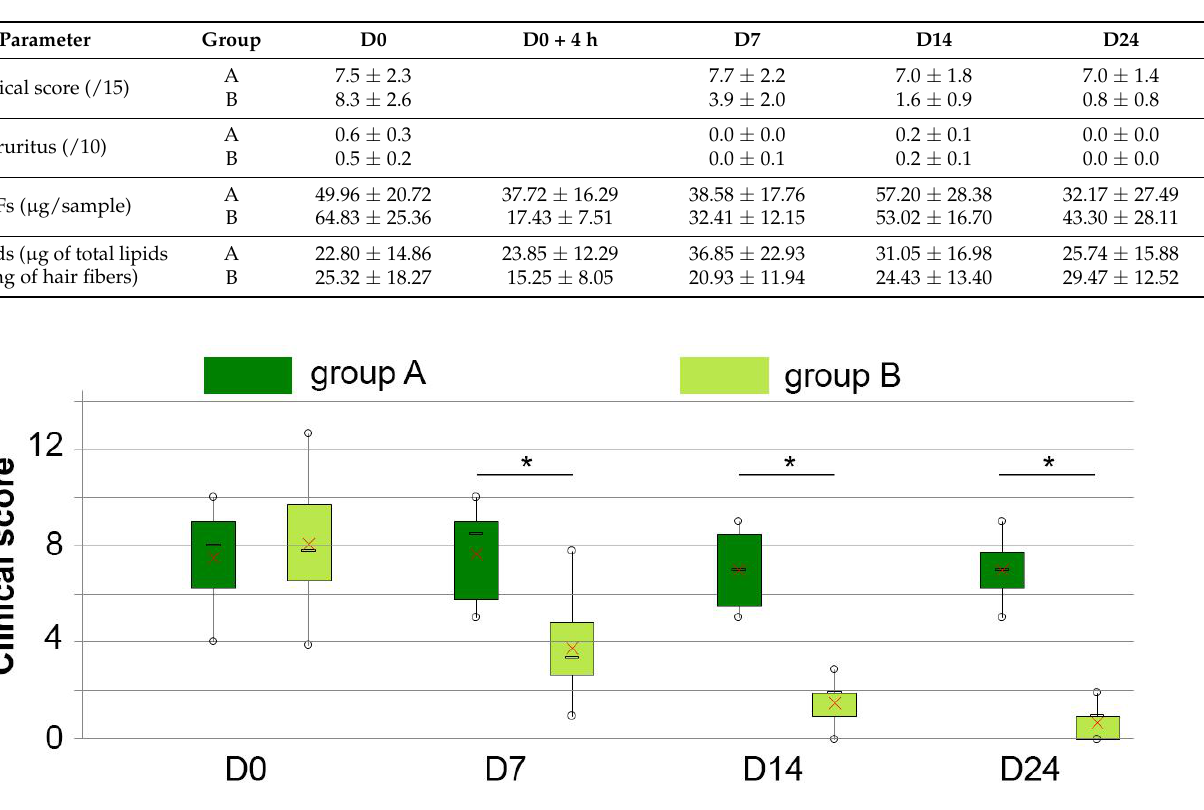
Table 3. Results of the clinical and biochemical parameters at different time-points of the two groups of dogs with keratinization disorders that were washed in plain water (group A) or received DOUXO ® S3 SEB shampoo and mousse (Ceva Santé Animale, France) (group B).